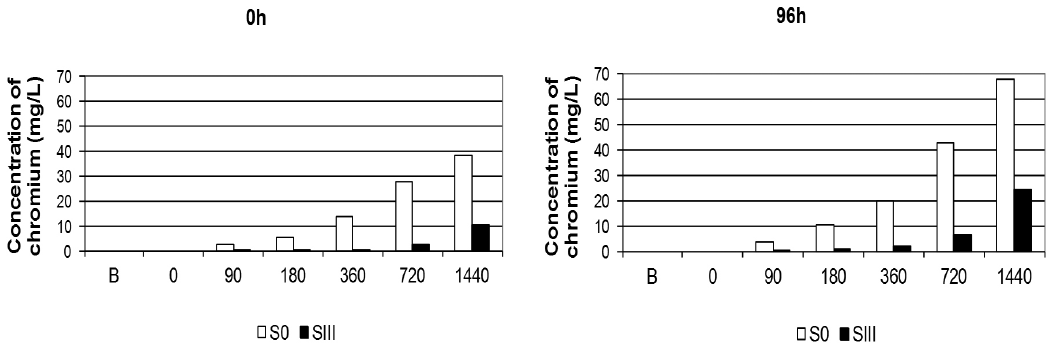
Figure 2. Chromium concentration in the water at the beginning (0h) and end (96h) of the tests with artificial sediment in Chironomus xanthus with (SIII) and without organic matter (S0). B: Controle (treatment with sand without contamination by